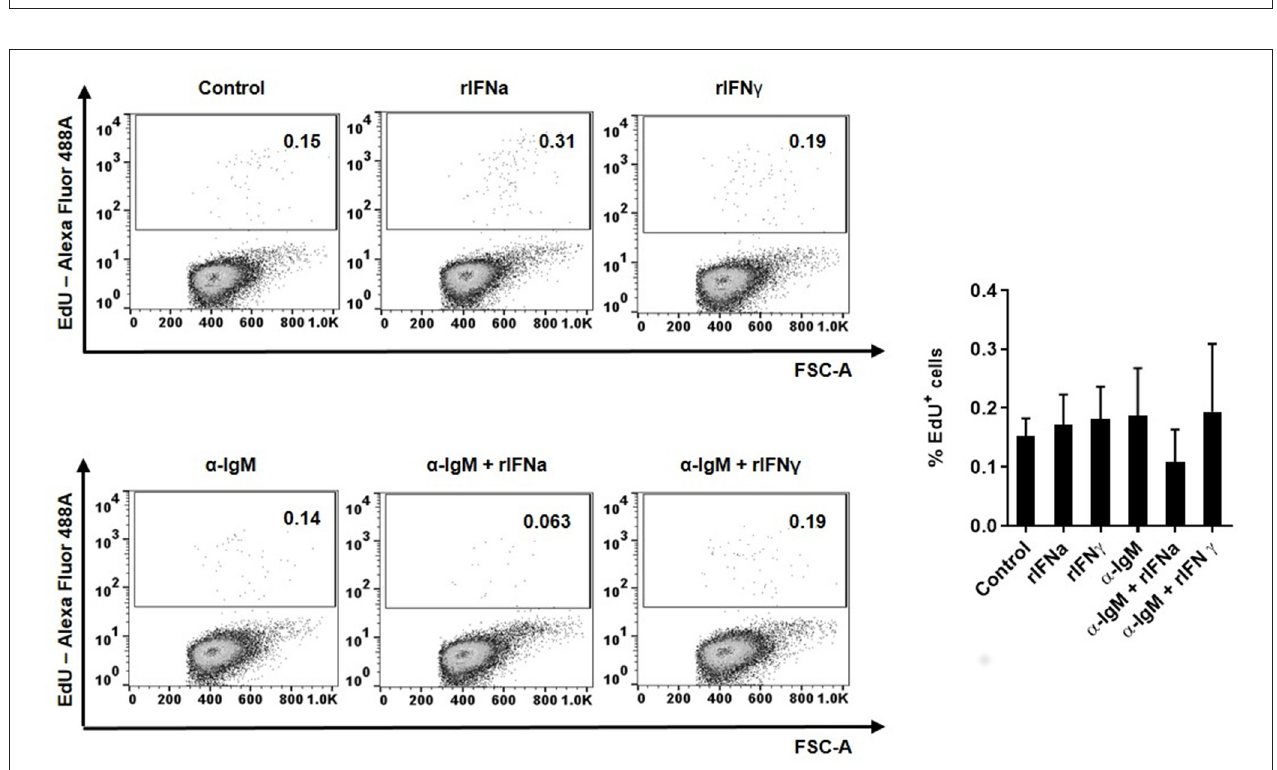
FIGURE 2 | Proliferative effects of type I and type II IFNs on blood IgM + IgD + B cells. The lymphoproliferative effects of rIFNa and rIFN γ were determined by incubating PBLs at 20 ◦ C with 50ng/ml rIFNa, 20ng/ml rIFN γ or media alone. For each condition, wells containing 10 µ g/ml of unlabelled anti-IgM were also included. After 72h, cells were labeled with EdU (1 µ M) and incubated for a further 24h. At that point, cells were labeled with anti-IgM and anti-IgD mAbs and the percentage of IgM + IgD + B cells with incorporated EdU (proliferating cells) determined as described in the Materials and Methods section. Representative dot plots are presented along with a graph showing the quantification of proliferating IgM + IgD + B cells (mean + SEM; n =